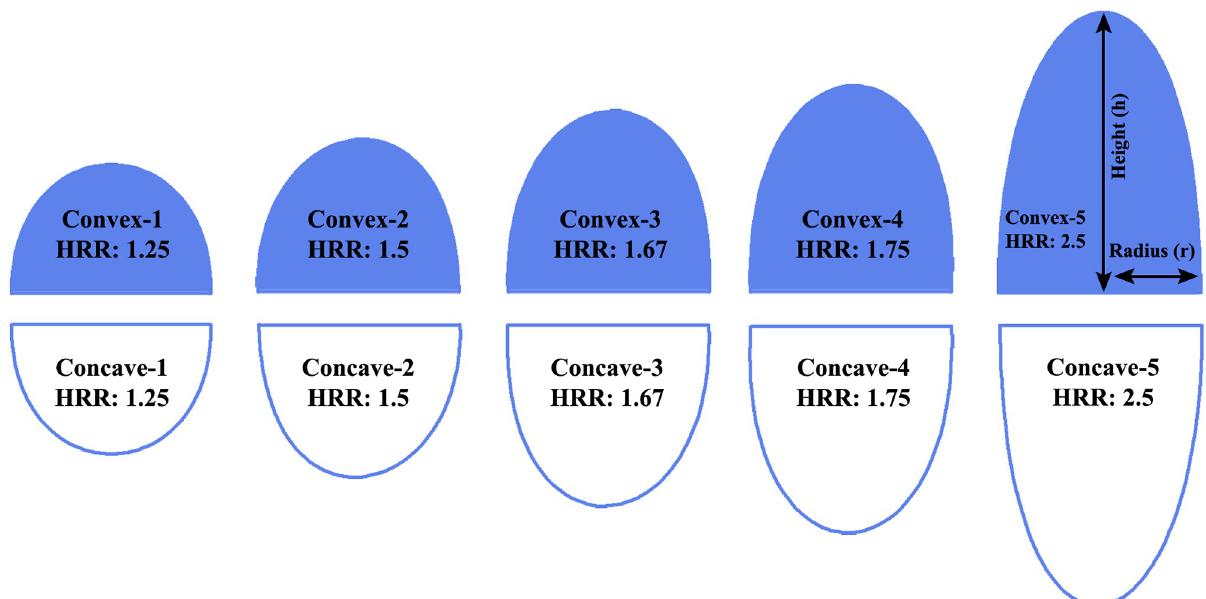
Fig 3. Different types of elliptical micro lenses engraved on the top of the substrate of the OLEDs.